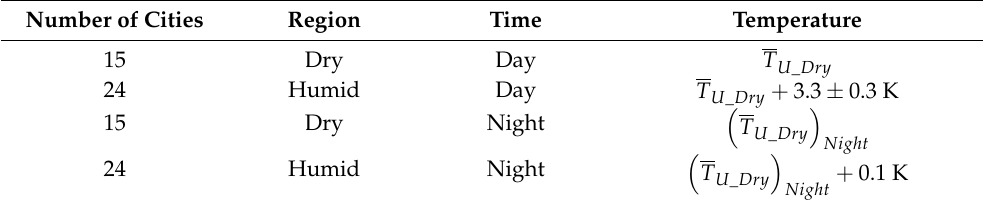
Table 1. Summary of cities and temperature differences of interest. Number of Cities Region Time